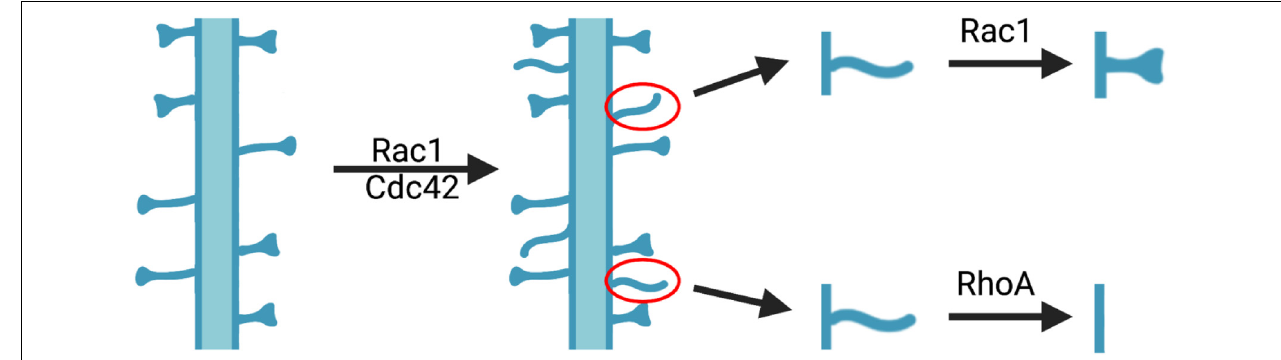
FIGURE 1 | Role of Rho GTPases in modulating dendritic spine density and morphology. The activation of Rac1 and Cdc42 leads to increased immature spines, some of which will undergo morphological changes to obtain mature morphology through Rac1-dependent mechanisms, whereas others will be eliminated by RhoA-dependent